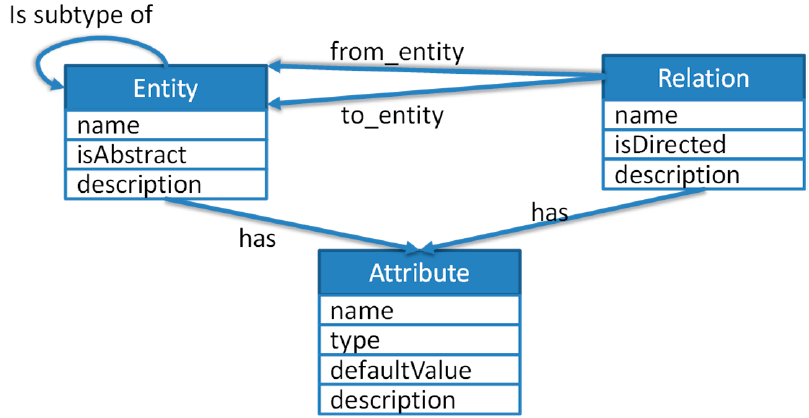
Figure 1. Excerpt of the meta-model.